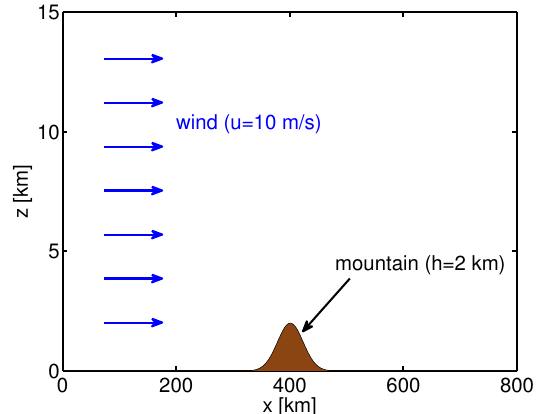
Fig. 1. The terrain profile chosen for our simulations consists of a Gaussian-shaped mountain ridge of 2km height and a half- √ width= ln2 a ’ 27km (Eq. 1) centered at x = 401km. The initial airstream has a uniform speed u = 10ms − 1 .